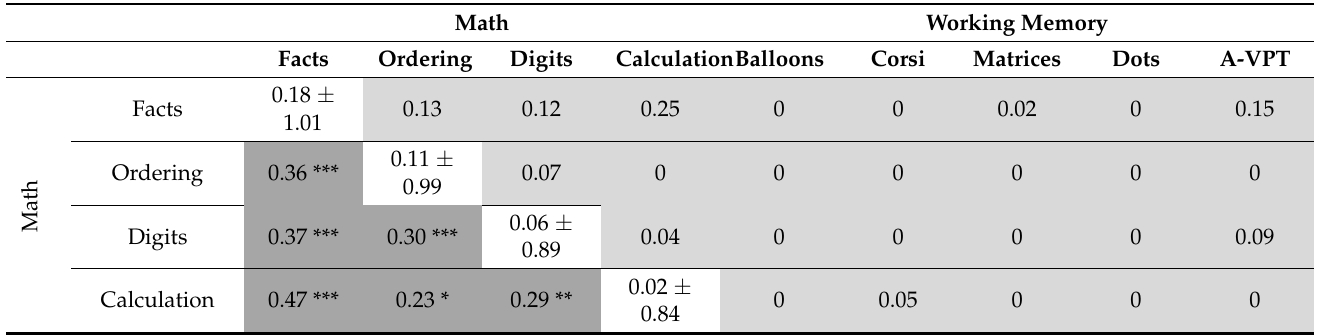
Figure 1. The left panel shows the network estimated by the Gaussian Graphical Model, adopting the EBIC Graphical LASSO method. The edges represent regularized partial correlations. Blue lines indicate positive associations. Red lines would have indicated negative associations (none observed). The size and the color saturation of the edges represent the intensity of the relationships. The nodes indicate the variables as follows: (1) Arithmetical facts; (2) Number ordering; (3) Transcoding digits (4) Written calculation; (5) Balloon recognition task; (6) Corsi test; (7) Sequential matrices; (8) Simultaneous dots; and (9) A-VPT. The right panel shows the centrality index. Strength centrality is higher if a node has a large number of strong direct connections with other nodes. The centrality index is standardized and expressed as z-scores. Table 1. The lower part (highlighted in dark grey) reports the simple correlations, measured with Pearson’s r. The upper part (highlighted in light grey) reports the network weights, which correspond to regularized partial correlations. The diagonal reports the mean z scores ± the standard